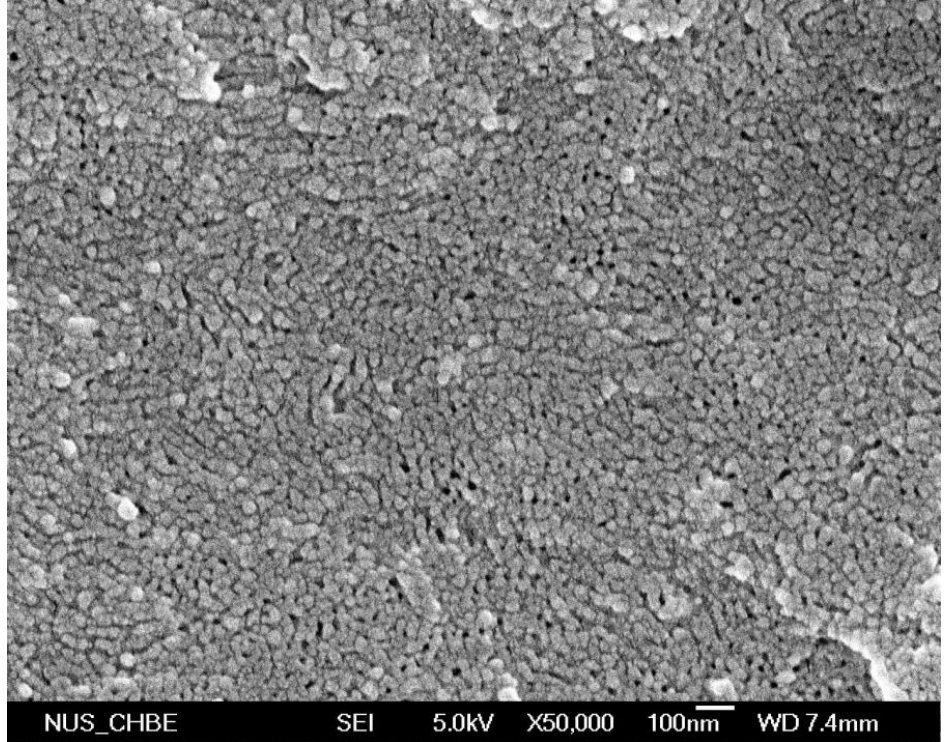
Figure A4. FE-SEM images of cross-linked diblock A100G4S-10 membrane (magnification 100,000 × ).